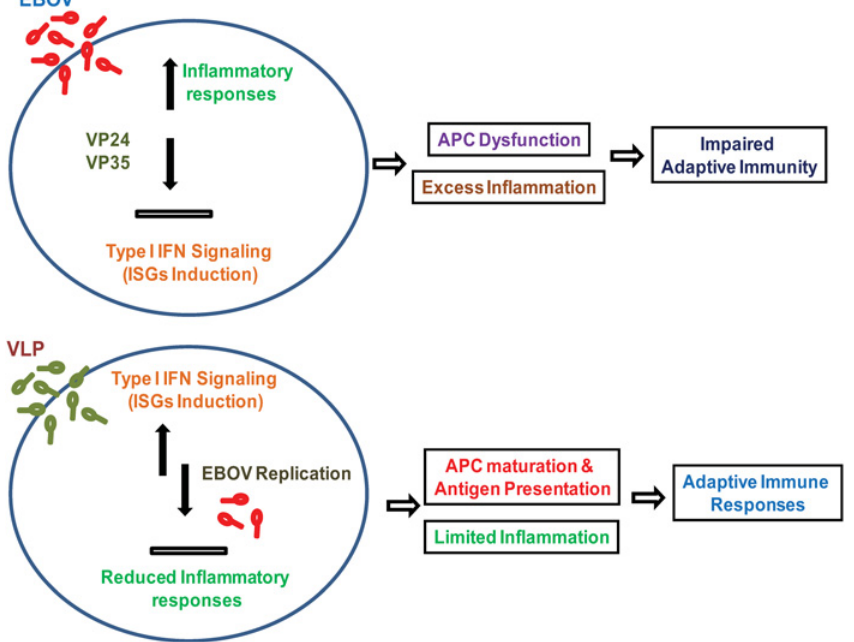
Fig 7. A model for VLP mediated post-exposure protection against EBOV infection. Top: EBOV infection in macrophages and DCs inhibits induction of type I IFNs and delays induction of ISGs via the mechanism of anti-IFN antagonism. Impaired type I IFN signaling delays induction of antiviral ISGs, and hinders maturation of macrophages and DCs and development of antigen presentation activity. It also inhibits prompt induction of negative regulatory ISGs that leads to exaggerated inflammatory responses. As a result, adaptive immunity is not adequately induced. Bottom: VLPs trigger timely induction of type I IFNs and ISGs by overcoming EBOV ’ s anti-IFN antagonism. This prompts rapid onset of anti-viral activity, simultaneously limiting exaggerated inflammatory responses and allowing maturation of antigen presentation function, which results in robust adaptive immune